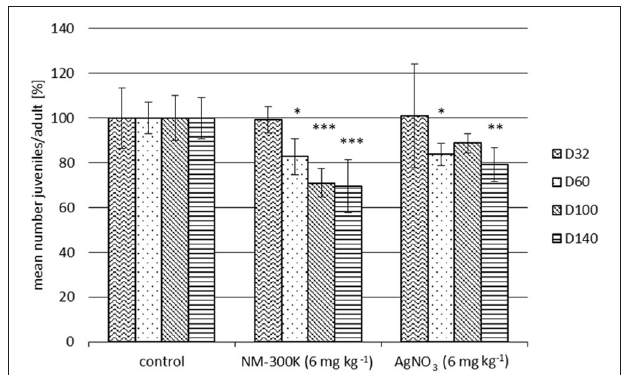
FIGURE 4 | Inhibition of F. candida reproduction in a 28-day test with manually spiked sludge compared to the corresponding sludge control. NM-300K or AgNO 3 were applied to the sewage sludge by manual spiking. The sewage sludge was applied to soil and incubated for 32, 60, 100, or 140 days before the tests were performed. Reproduction per adult is normalized to the corresponding sludge control (100%). Each column represents mean ± SD of 5 replicates. Statistical significances to the respective control: * p ≤ 0.05, ** p ≤ 0.01, *** p ≤